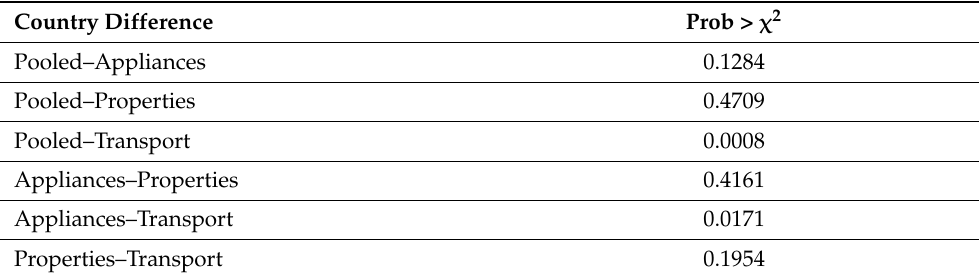
Table 8. Wald test results for the pooled and technological subsample models (households).